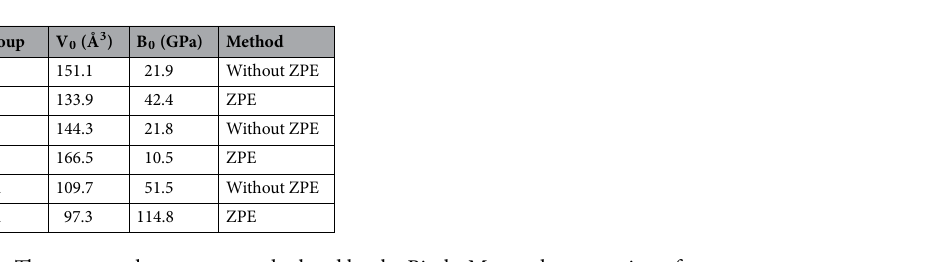
Table 2. The structural parameters calculated by the Birch–Murnaghan equation of